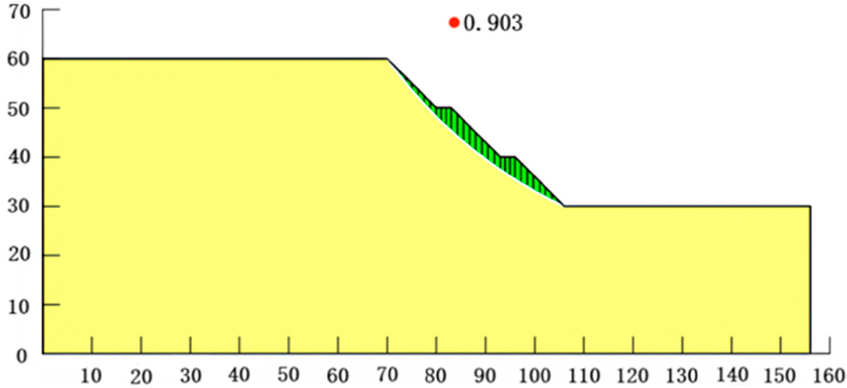
Table 1. Each grade of multi-stage loess slope changes the calculation condition.